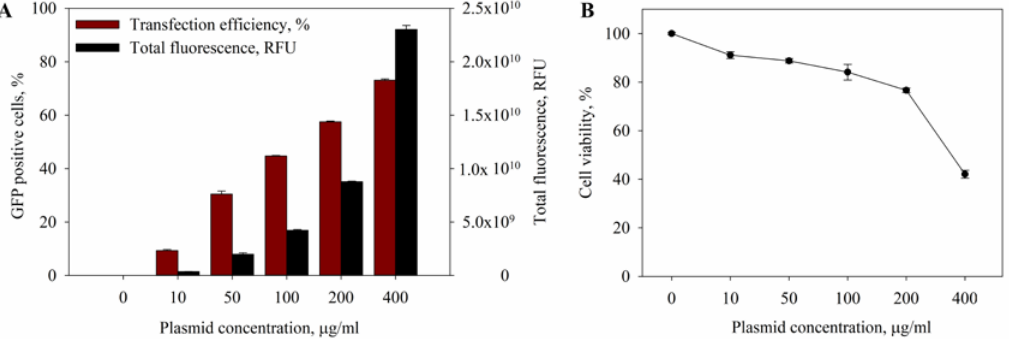
Figure 1. The dependence of the percentage of green fluorescent protein (GFP)-positive cells ( A ) and cell viability ( B ) on the concentration of GFP-coding plasmid. One high voltage (HV) pulse (1400 V / cm, 100 µ s) was used. Error bars represent standard error of mean (SEM).